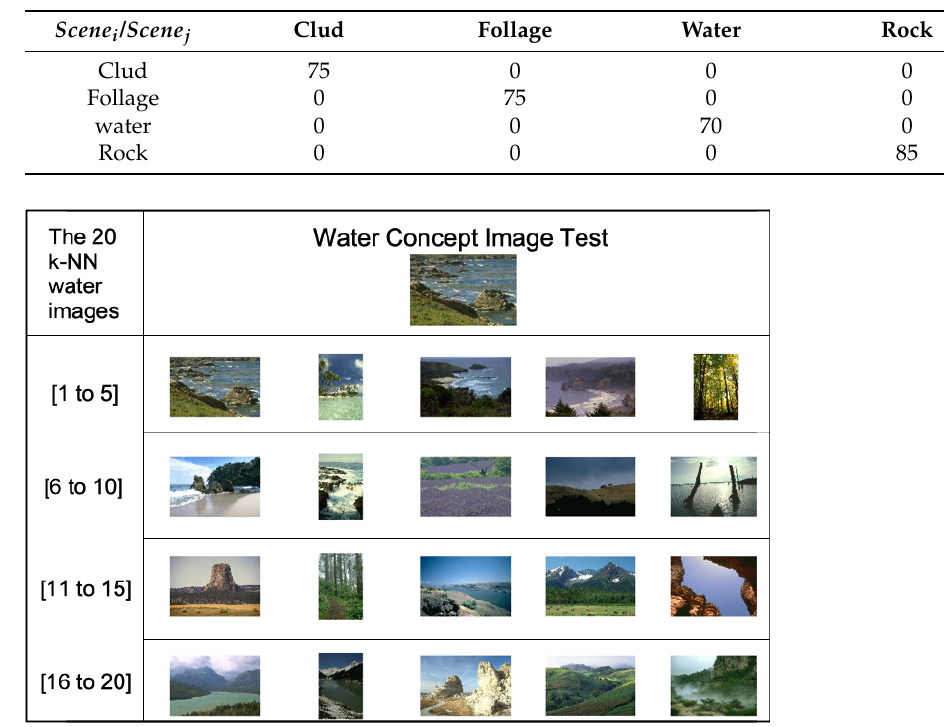
Table 4. Confusion matrix for elements constitutive of natural scenes.